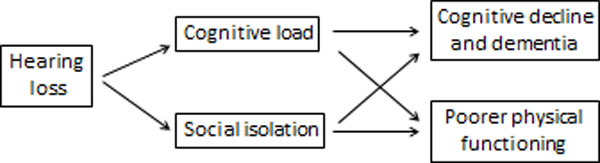
Conceptual model of the association of hearing loss with cognitive and physical functioning in older adults (from F. Lin, 2012)[3]